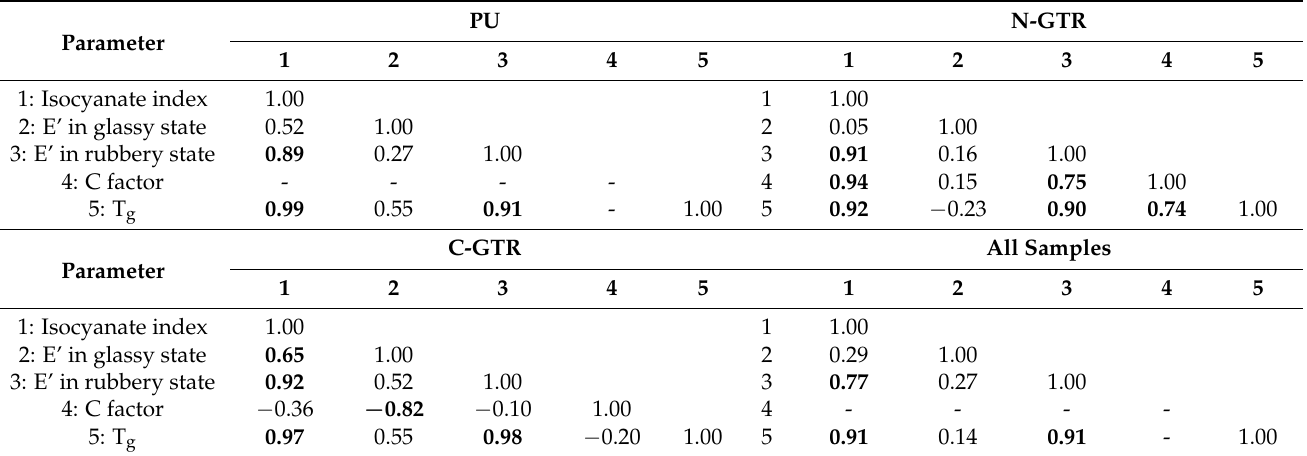
Table 4. PCC values quantifying the strength of the relationship between the isocyanate index and particular thermomechanical parameters of prepared